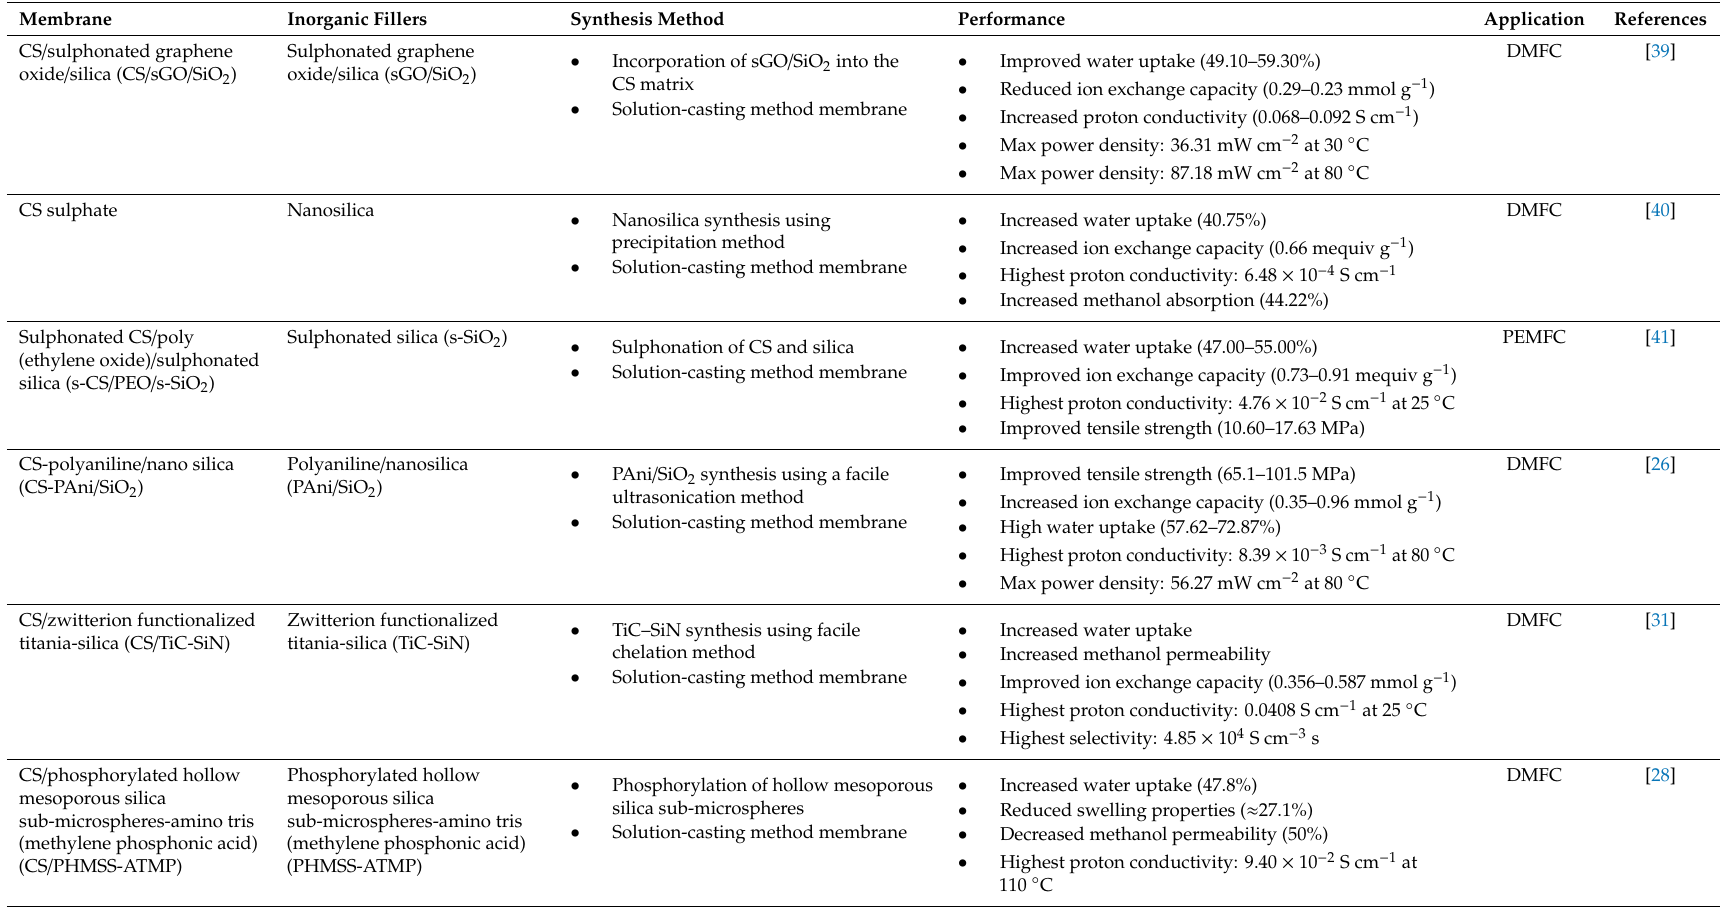
Table 1. Applications of hygroscopic oxide fillers in CS hybrid